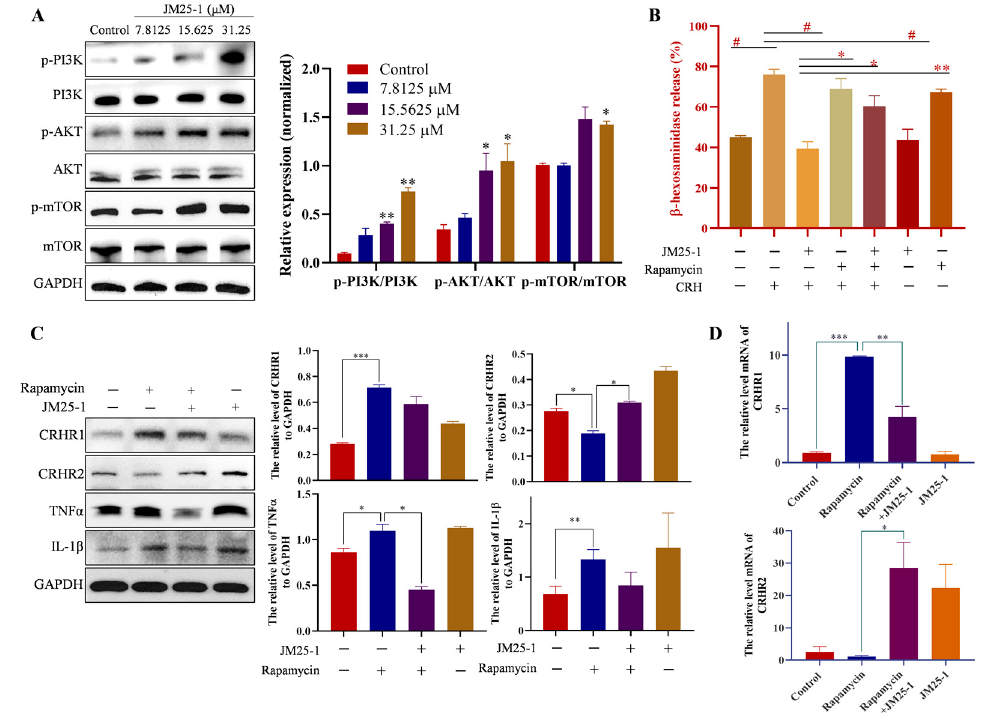
Figure 7. JM25-1 reduces degranulation and cytokine through the PI3K/AKT/mTOR/CRHR signal- ing pathway. HMC-1 cells were treated with JM25-1 at continuous concentrations for 24 h. ( A ) Western bolt was used to analyze the expression of p-PI3K, PI3K, p-AKT, AKT, p-mTOR, mTOR and GAPDH. Bars, S.D. * p ≤ 0.05, ** p ≤ 0.01, VS. the Control. ( B ) Cells treated with JM25-1 (31.25 µ M) and Rapamycin (400 nM) regulate the release of β -hexosaminidase in CRH (500 nM) induced HMC-1. bars, S.D. # p ≤ 0.05, vs. the CRH group; * p ≤ 0.05, ** p ≤ 0.01, vs. the CRH + JM25-1 group. ( C ) HMC-1 was treated with JM25-1 or co-treated with Rapamycin for 24 h. The protein level of CRHR1, CRHR2, TNF α , IL-1 β and GAPDH was analyzed by Western blot. ( D ) And the mRNA level of CRHR1 and CRHR2 was detected by real-time PCR. Bar chart indicates the relative expression of target proteins to GAPDH. bars, S.D. * p ≤ 0.05, ** p ≤ 0.01, *** p ≤ 0.001, vs. the Rapamycin group.